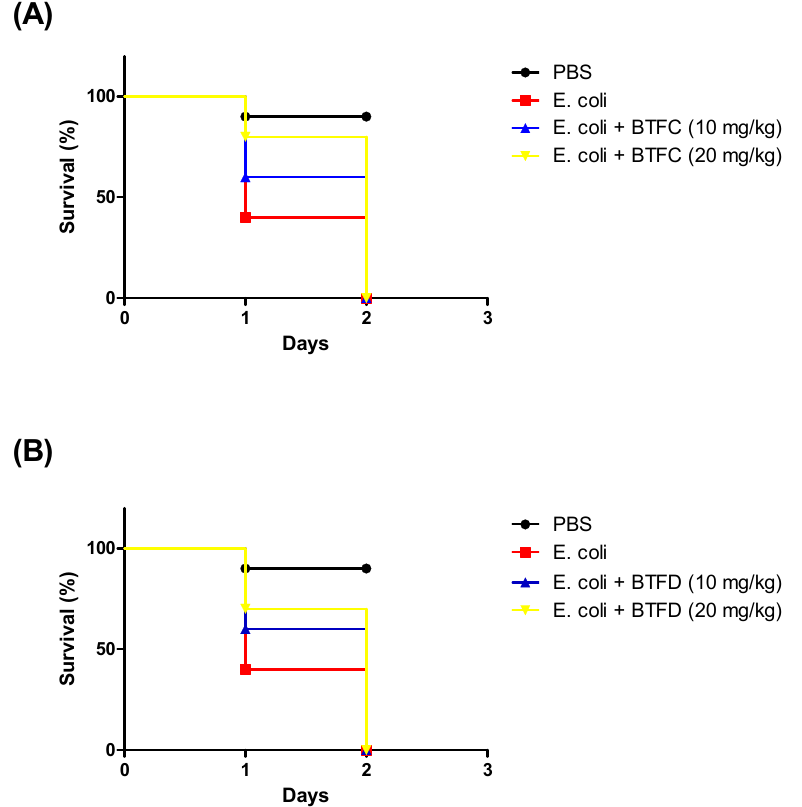
Figure 5. E ff ects of fractions from methanolic extract of Buchenavia tetraphylla leaves (BTFC and BTFD) on the survival of Tenebrio molitor larvae challenged with Escherichia coli 042. ( A ) E ff ects of BTFC on the survival of Tenebrio molitor larvae challenged with E. coli 042. ( B ) E ff ects of BTFD on the survival of Tenebrio molitor larvae challenged with E. coli 042. The larvae (n = 10 / group) received a lethal dose of EAEC 042 and after 2 h were treated with fraction BTFC and BTFD (at 10 mg / kg or 20 mg / kg). Larvae treated with phosphate-saline bu ff er (PBS) or EAEC 042 were used as negative or positive controls, respectively. In this set of assays, larvae survival was recorded each 24 h. The experiment was repeated three times.